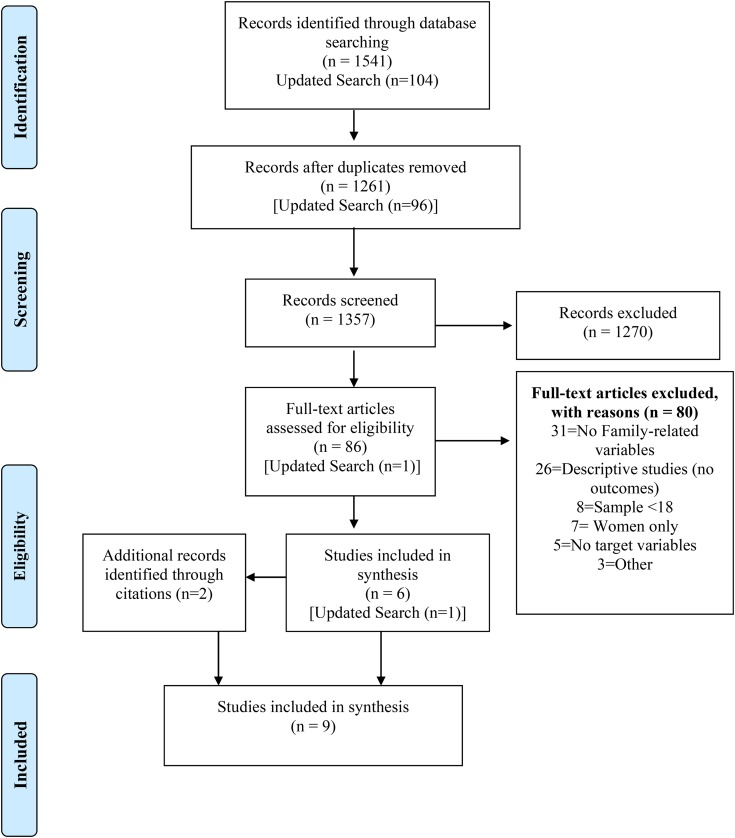
Search flow diagram.